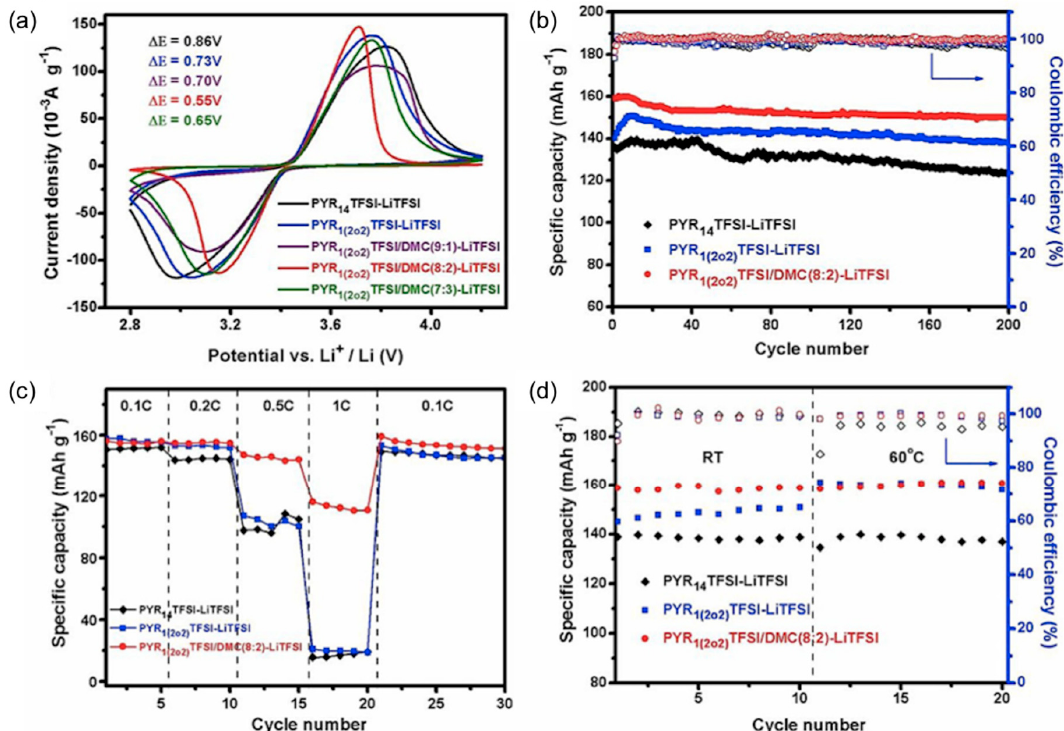
Figure 13. ( a – c ) Performance of various electrolytes at room temperature with LFP/Li: ( a ) CV curves, ( b ) cycling performance at 0.2 C, ( c ) rate performance at indicated C-rates and ( d ) cycling performance of RT and high temperature (60 °C). Reprinted with permission from Zhang et al.[209].